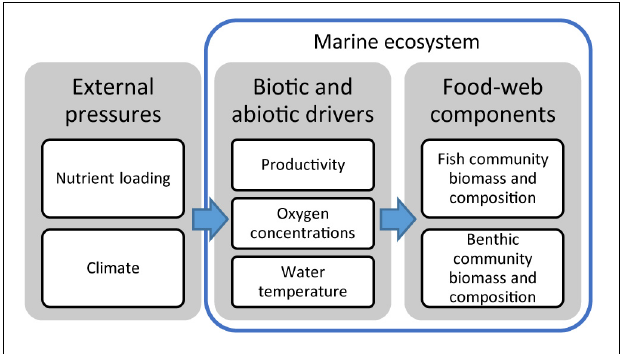
FIGURE 1 | Overview of interacting environmental drivers and marine ecosystem components considered in this